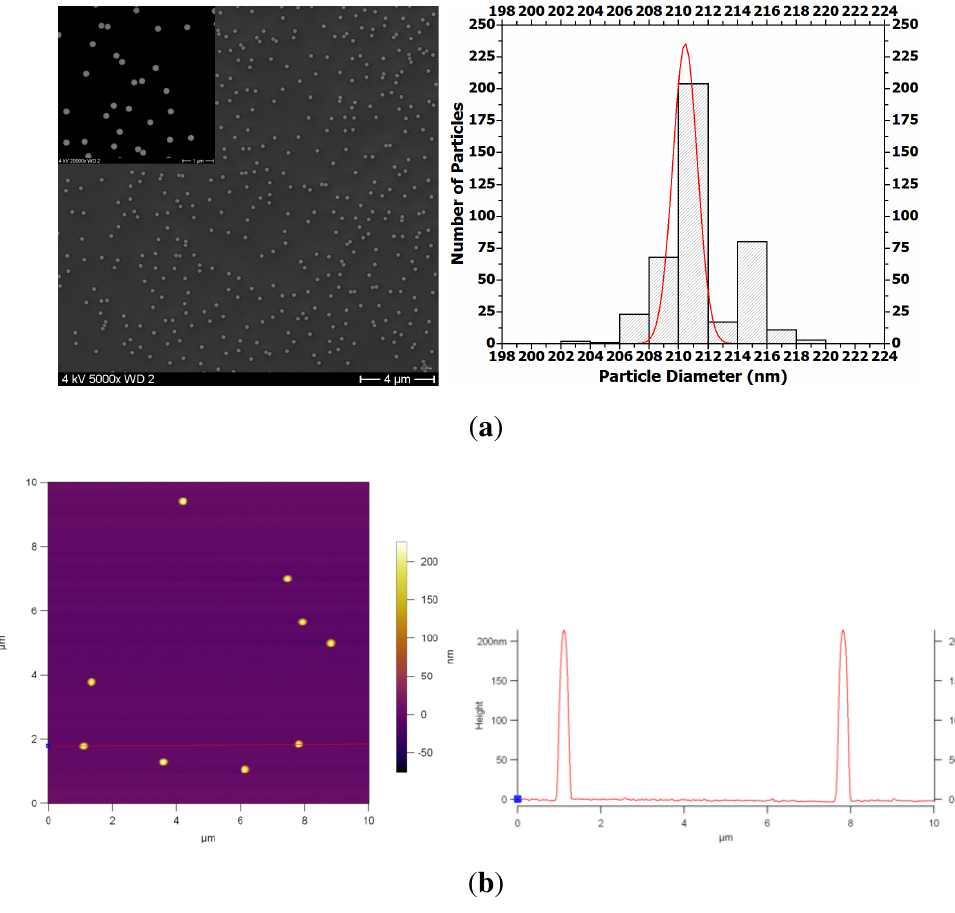
Figure 1. SEM image and the corresponding particle size distribution histogram of PS NPs, fitted with a Gaussian curve ( a ); AFM height profile of the PS NPs together with the cross-sectional diagram with peak heights ( b ).